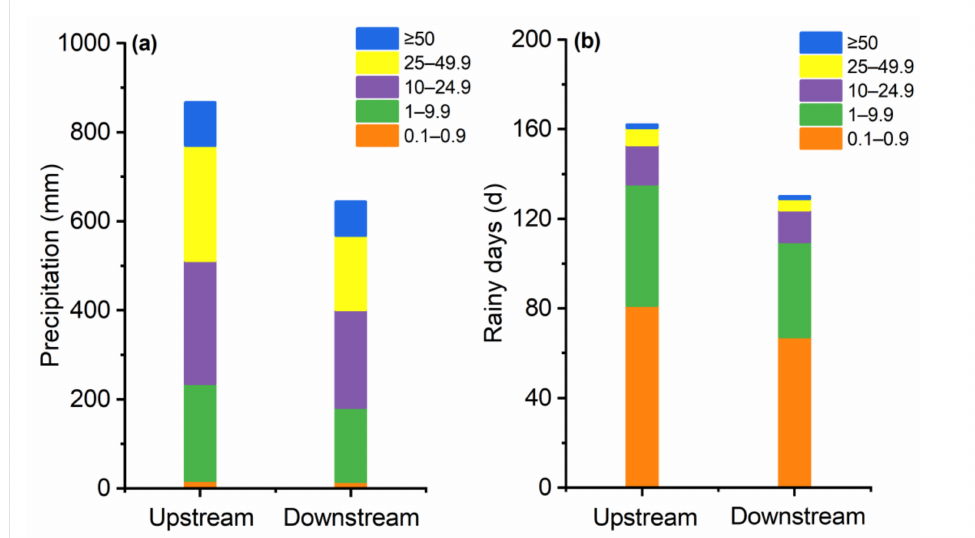
Figure 2. ( a ) Precipitation and ( b ) rainy days in each intensity in the lower and upper